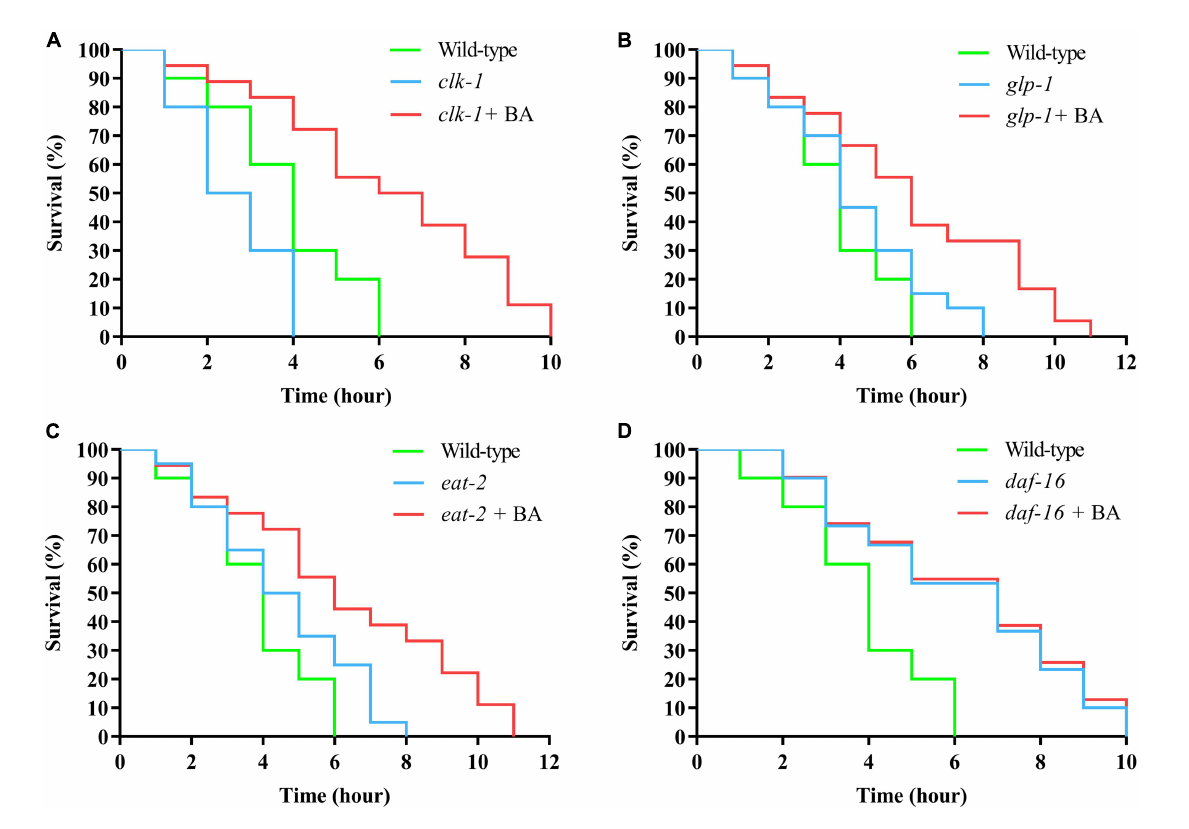
FIGURE5 DAF-16 is required for betulinic acid (BA)-induced oxidative stress resistance. The classical longevity mutants, including clk-1 (A) , glp-1 (B) , eat-2 (C) , and daf-16 (D) , were tested for juglone-induced oxidative stress. The Kaplan-Meier survival curves were generated to analyze the effects of